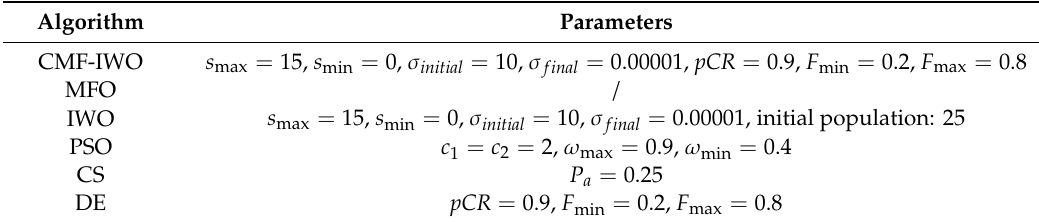
Table 2. The parameters settings of each algorithm.